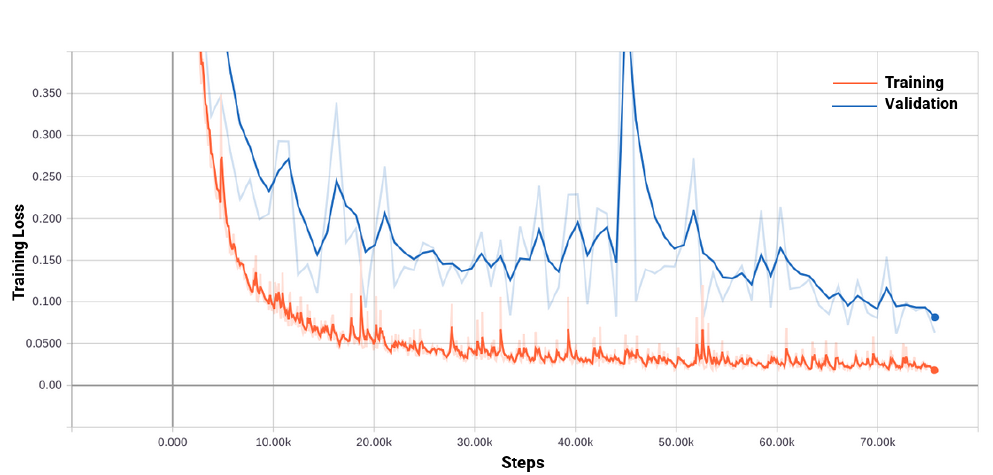
Figure 5. The network’s training losses. Orange lines represent the loss on the training set; blue lines represent the loss on the validation